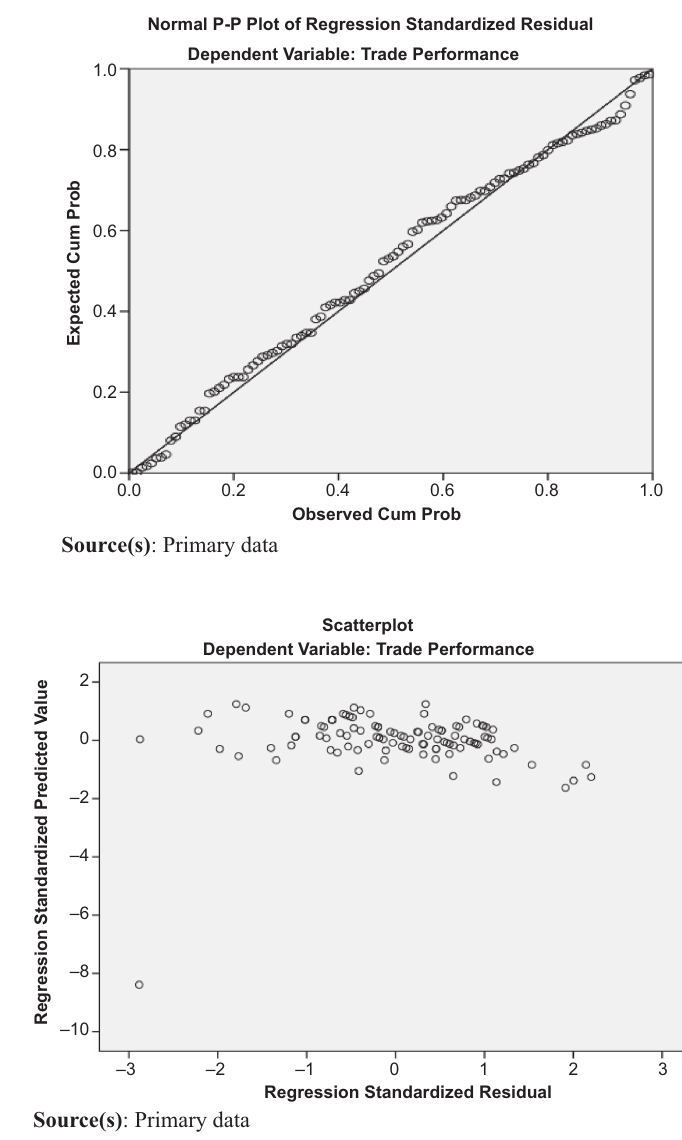
Figure 3. Graphical presentation of homogeneity